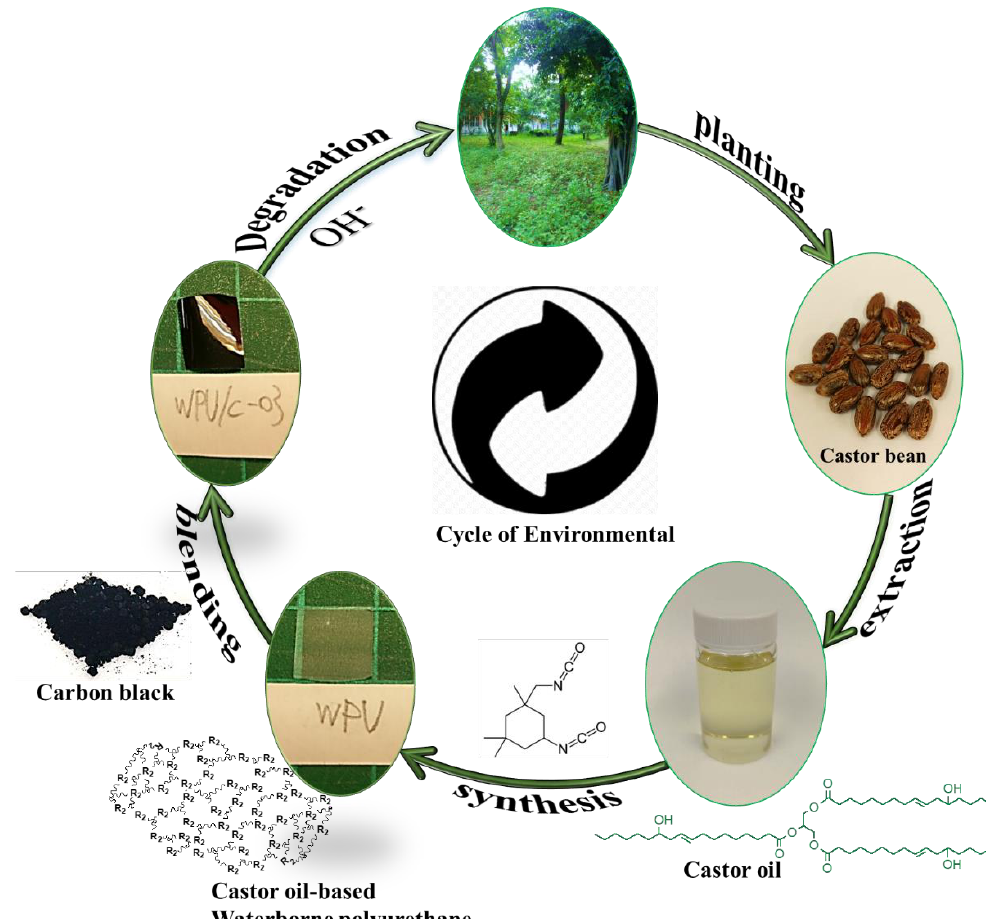
Figure 1. Schematic of environmentally friendly CB/WPUs.